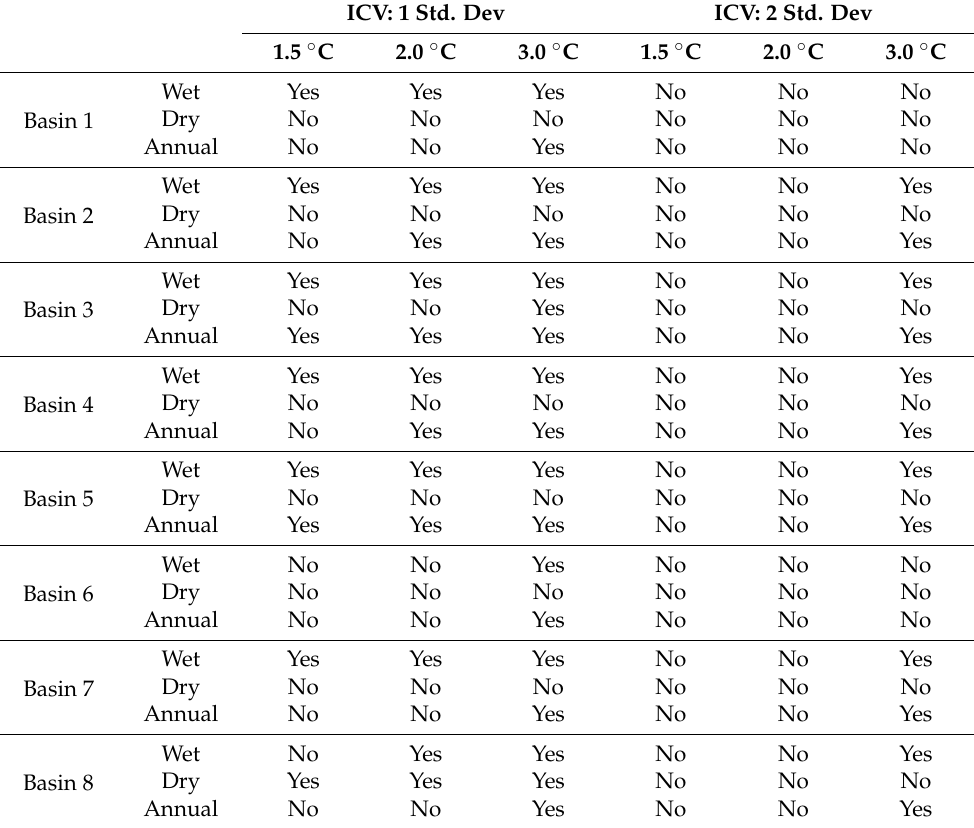
Table 4. Summary chart showing whether or not time of emergence will occur under different levels of warming in the NEUS